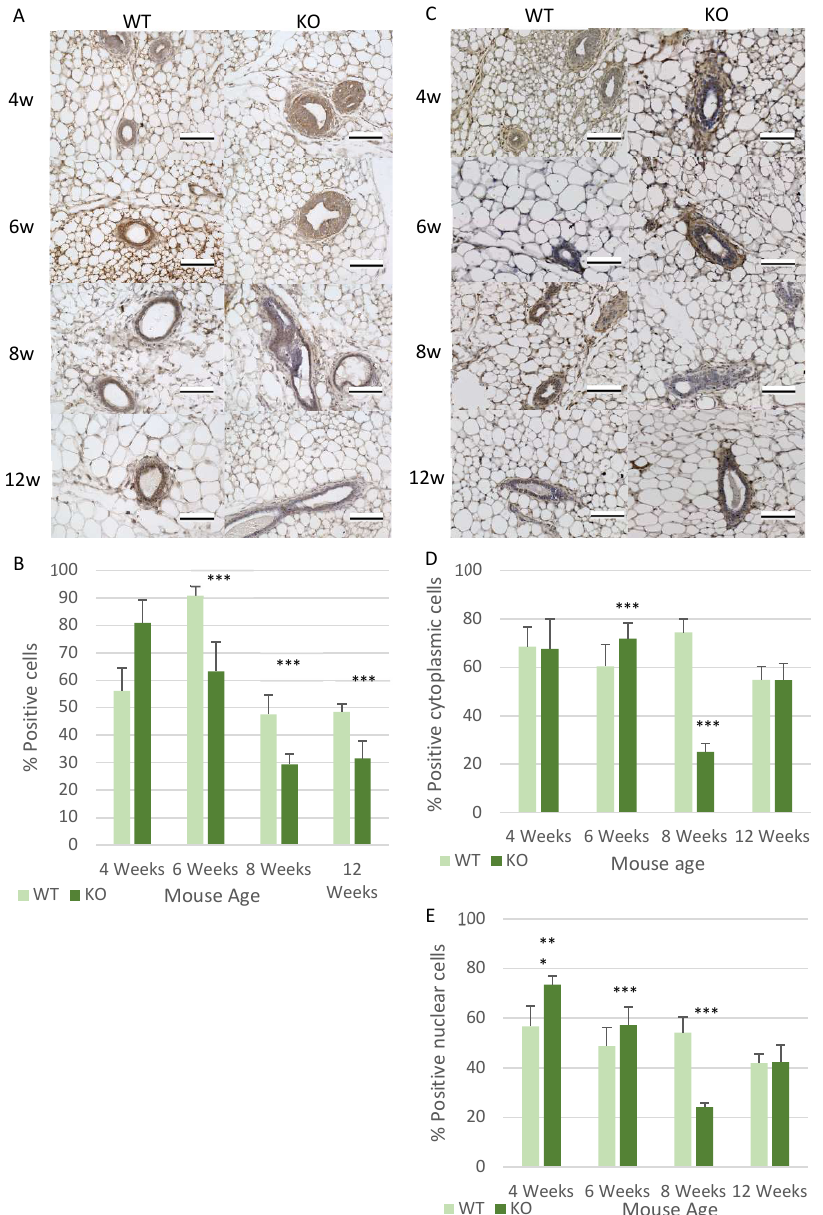
Figure 6. Csmd1 KO causes changes in the expression of cell adhesion associated proteins. ( A ) Images of Fak expression within the ducts of the mammary glands at all ages in both the WT and KO mice. ( B ) Graph highlighting the changes in Fak expression in each duct at the various ages between the WT and KO mice, with the average expression of Fak per duct being shown (*** p < 0.001). The numbers of animals for each time point ( n = 6 WT; n = 6 KO), 6-week-old mice ( n = 8 WT; n = 7 KO), 8-week-old mice ( n = 7 WT; n = 7 KO), 12-week-old mice ( n = 7 WT; n = 7 KO) ( C ) Images of Slug and Snail expression within the ducts of the mammary glands at all ages in both the WT and KO mice. ( D ) Graph highlighting the changes in cytoplasmic levels of Slug and Snail expression at the various ages between the WT and KO mice, with the average expression of Slug and Snail per duct being shown (*** p < 0.001). ( E ) Graph highlighting the changes in nuclear Slug and Snail expression at the various ages between the WT and KO mice, with the average expression of Fak per duct being shown (*** p < 0.001). The numbers of animals for each time point included ( n = 6 WT; n = 6 KO), 6-week-old mice ( n = 8 WT; n = 7 KO), 8-week-old mice ( n = 7 WT; n = 7 KO), 12-week-old mice ( n = 7 WT; n = 7 KO). All images were taken using an x40 objective, with all scale bars 100 µ